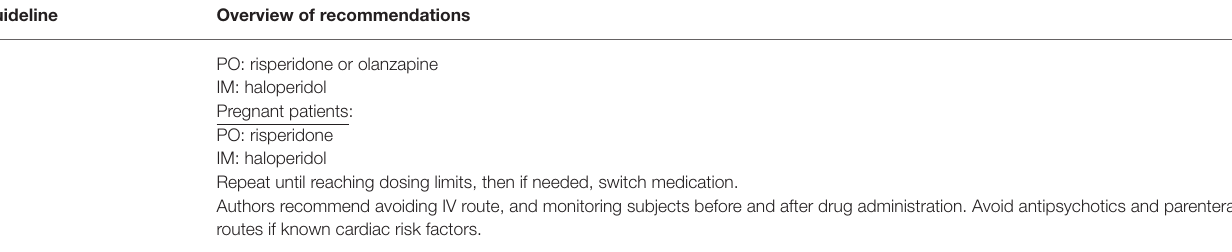
Guideline Overview of recommendations